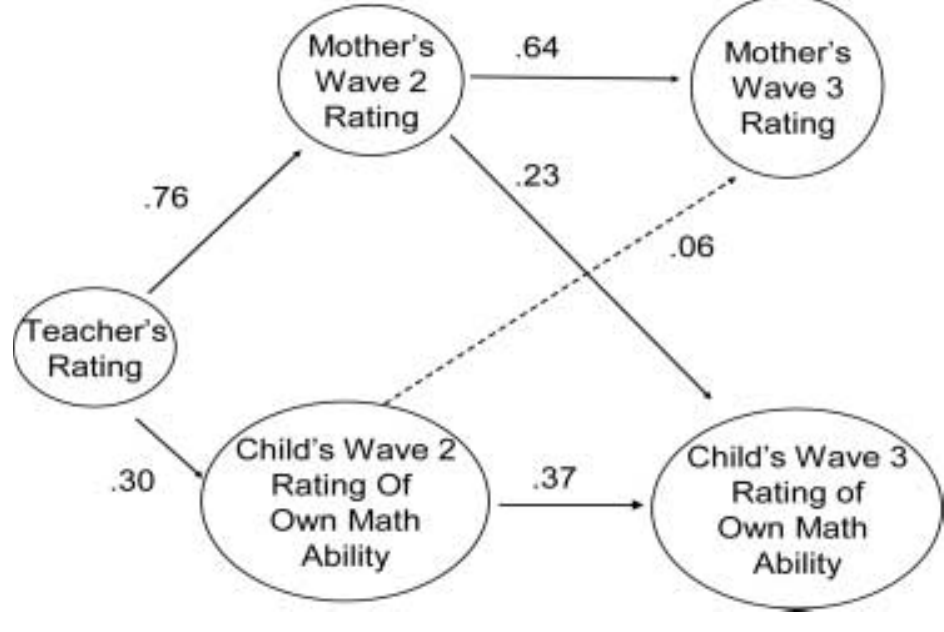
Figure 2. Correlations of teacher and parent ratings of child’s math